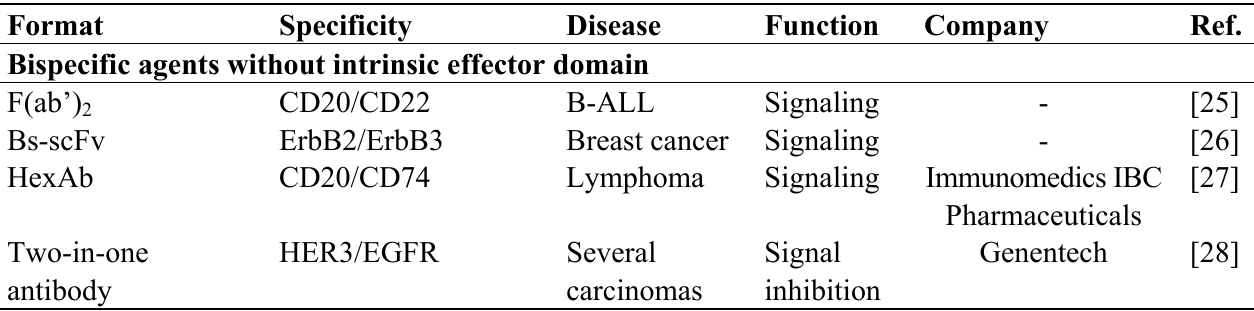
Tabel 1. Dual-targeting